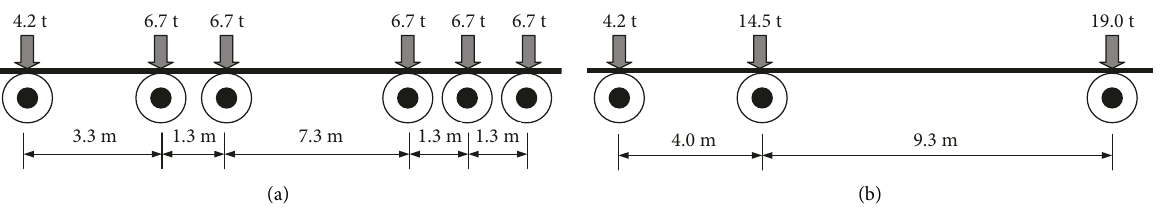
Figure 14: Suggested fatigue truck models. (a) Fatigue vehicle model. (b) Simplified fatigue vehicle